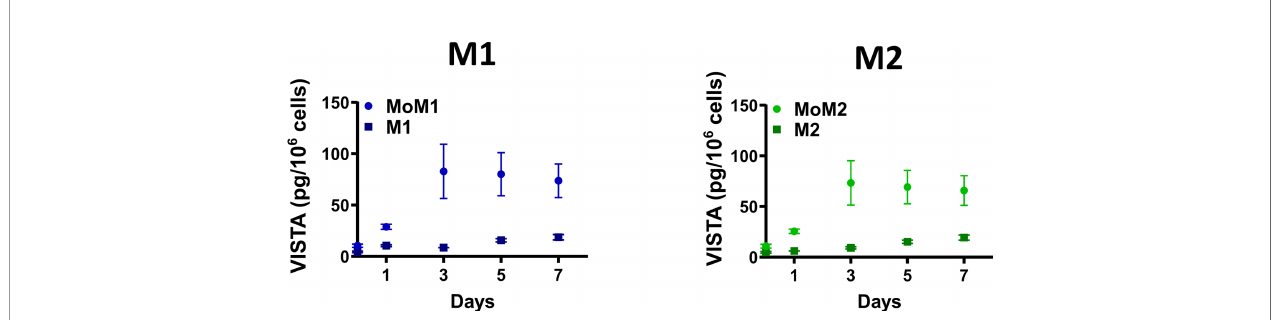
FIGURE 2 | Differentiating monocytes but not fully differentiated macrophages release soluble VISTA. Monocytes were differentiated into M1 (MoM1, light-blue circles) or M2 (MoM2, light-green circles) macrophages for 7 days with GM-CSF or M-CSF, respectively. Medium was then replaced and fully differentiated M1 (dark- blue squares) and M2 (dark-green squares) macrophages were cultivated for another 7 days. VISTA concentration in culture medium was determined every second day using a VISTA sandwich ELISA. Data are the mean values ± SEM (n=3-11).